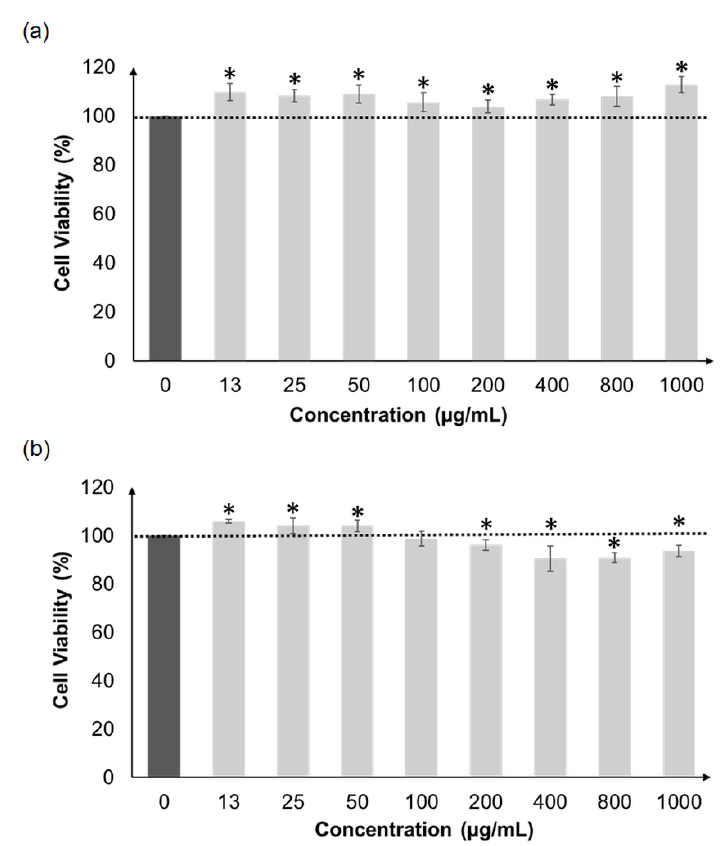
Figure 3. Cellular viability of HaCaT cells after pre-treatment with CNL ( a ) and CNS ( b ) at various concentrations (13 to 1000 µ g/mL). All measurements were performed in triplicate and are expressed as mean ± standard deviation. Data were analyzed by comparing samples of different concentrations with untreated controls (100% viability) using the unpaired sample t -test. Values with the symbol * are significantly different at p < 0.05. (CNL: Clinacanthus nutans leaf extract; CNS: Clinacanthus nutans stem extract).